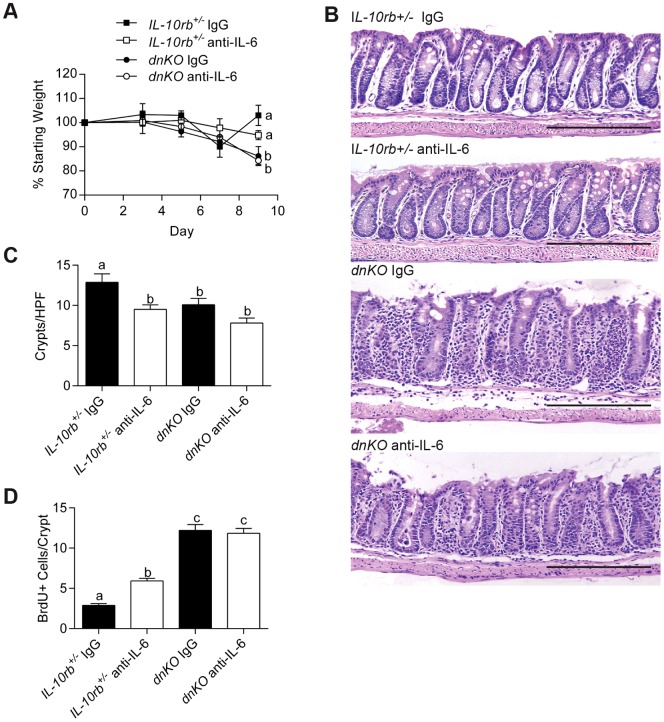
IL-6 inhibition after colitis induction did not inhibit epithelial proliferation but did not improve disease.Three days after induction of colitis in dnKO and IL-10rb+/- littermate controls, 500 µg anti-IL-6 antibody or control IgG was administered to mice three times weekly. Mice were sacrificed 9 days after induction of colitis. 6–8 mice per group in two independent experiments were analyzed. (A) Plot of the average percent of starting weight ± SEM shown for indicated groups of mice. Mice were weighed every three days. (B) Representative H+E-stained sections of descending colons from each group of mice. Bars = 500 µm. (C) Graph of the mean number of crypts/high-powered field ± SEM of the descending colon per animal. (D) Graph of the average number of BrdU+ cells/crypt ± SEM. One-way analysis of variance: (A) F = 4.88, P = 0.016; (C) F = 21.14, P<0.0001; and (D) F = 68.24, P<0.0001. Means with different letters are significantly different by Bonferroni's multiple comparison test.